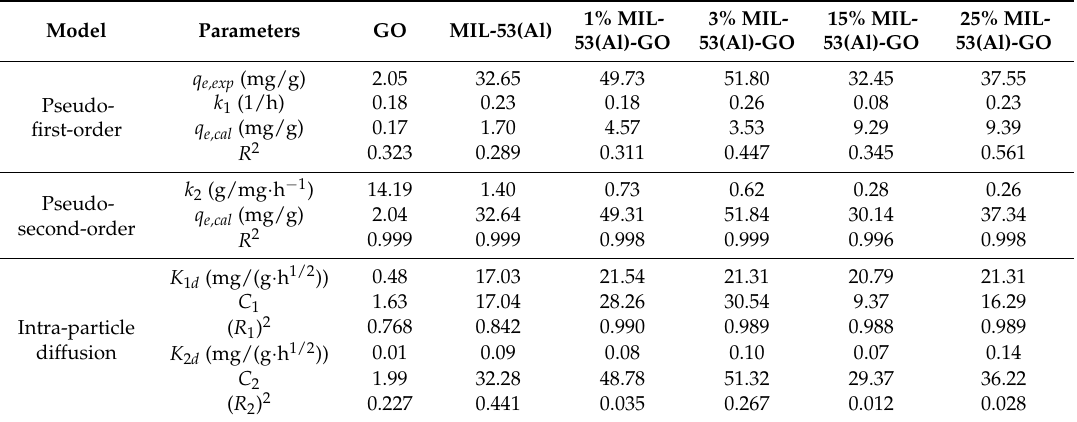
Table 1. Adsorption kinetics parameters of As(III) adsorption on GO, MIL-53(Al) and MIL-53(Al)- GO